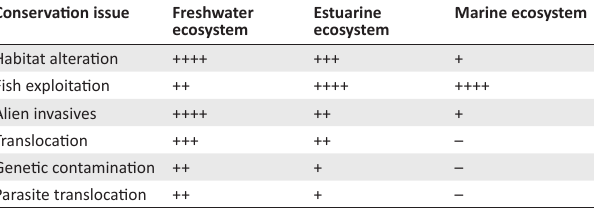
TABLE 1: Estimates of the relative importance of current major fish conservation issues in (1) freshwater, (2) estuarine and (3) marine ecosystems in South